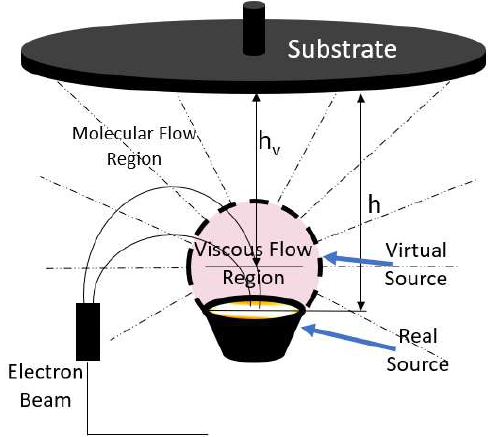
Figure 2. Schematic diagram of virtual evaporation source with regions of viscous flow and molecular flow; h is the height of substrate to the real source surface; h v is the height of substrate to the center of the virtual source.